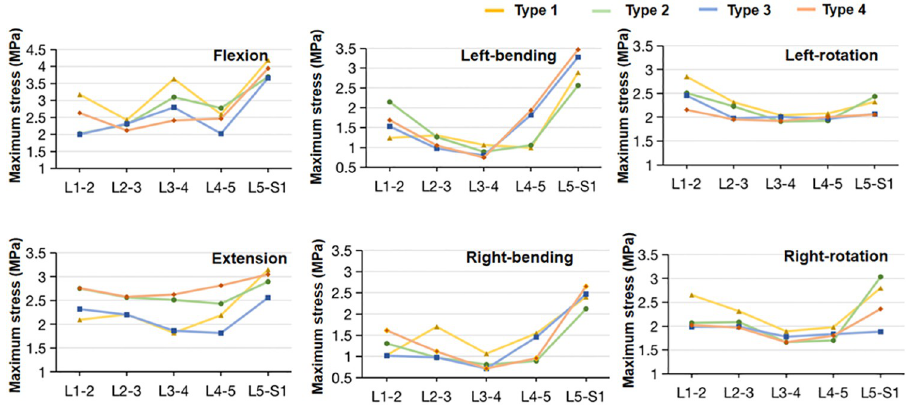
Fig 9. Maximum Von Mises stress of the annulus fibers of the lumbar-sacral segments in the four sagittal type models under all six loading conditions.